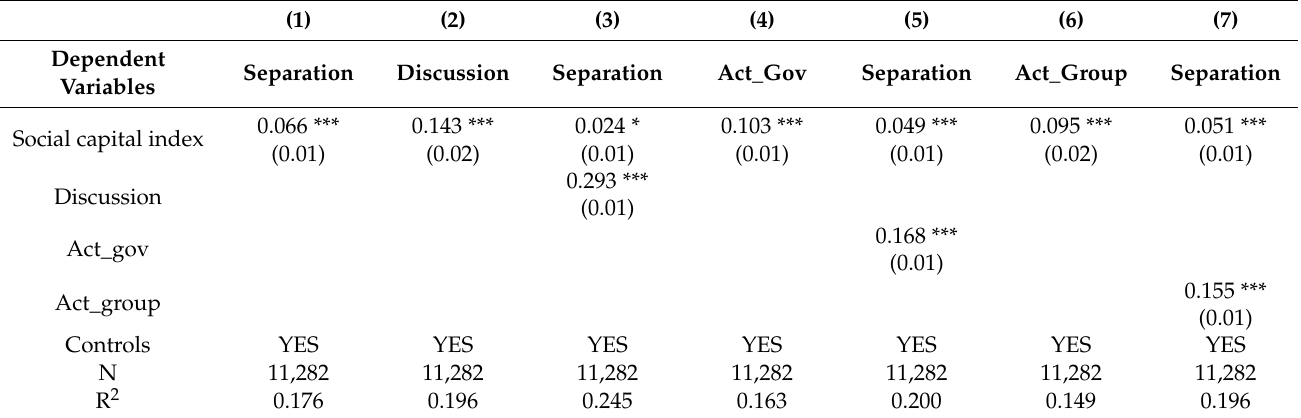
Table 6. Mediating effect of social learning: environmental protection